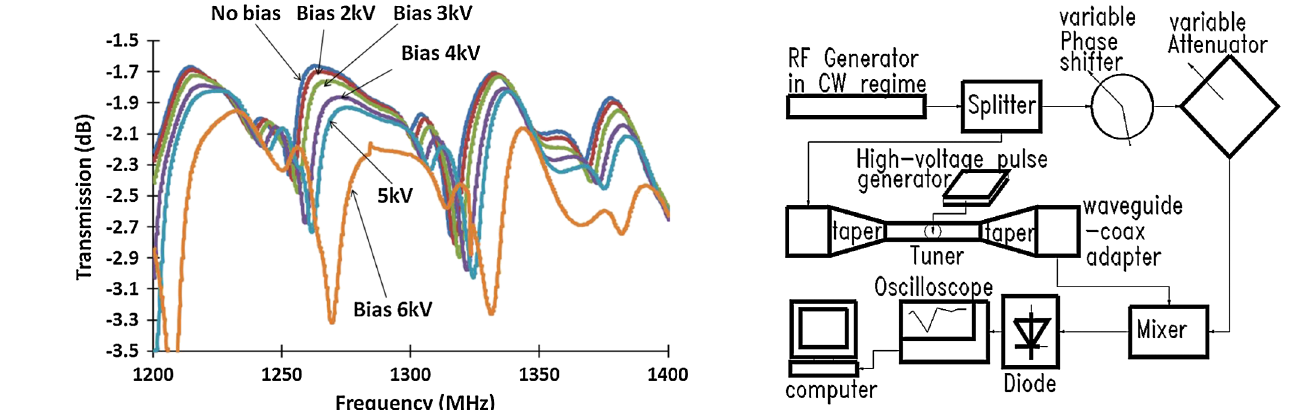
FIG. 8. The transmission drops when the voltage grows (see the magnitude change at 1.3 GHz).